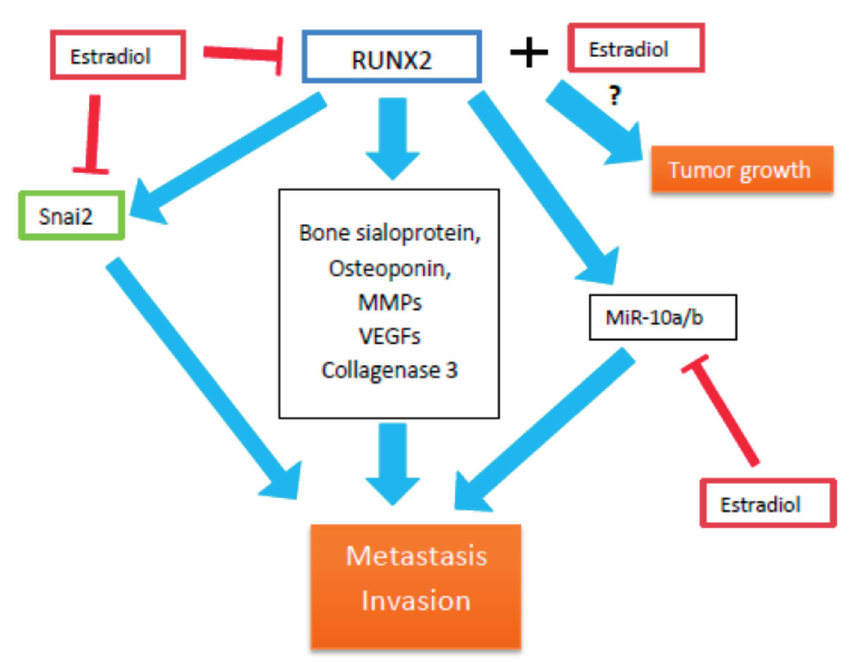
Figure 4. Important role of RUNX2 in estrogen-dependent breast cancer development and progression. Blue arrows indicate positive influence, while red are negative. Snai2: breast cancer-related transcription factor; MMPs: matrix metalloproteinase; VEGF: vascular endothelial growth